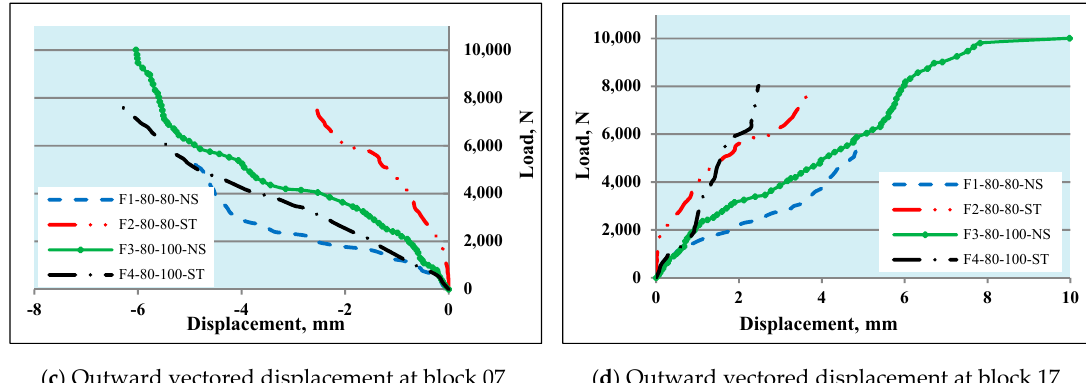
Figure 13. Load vs. outward displacements of self-form masonry arches.